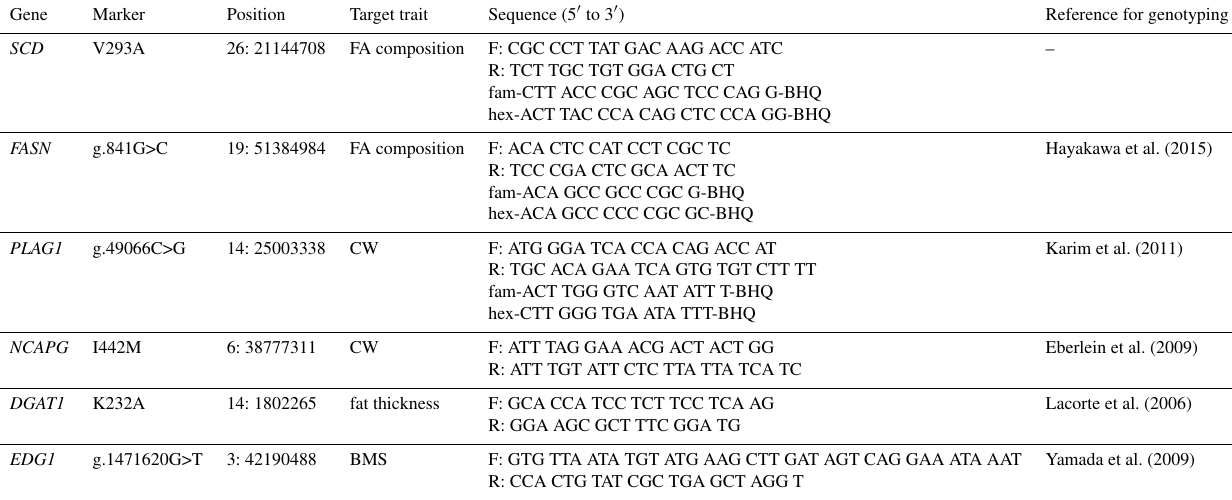
Table 2. Marker information for genotyping. Gene Marker Position Target trait Sequence (5 (cid:48) to 3 (cid:48) )